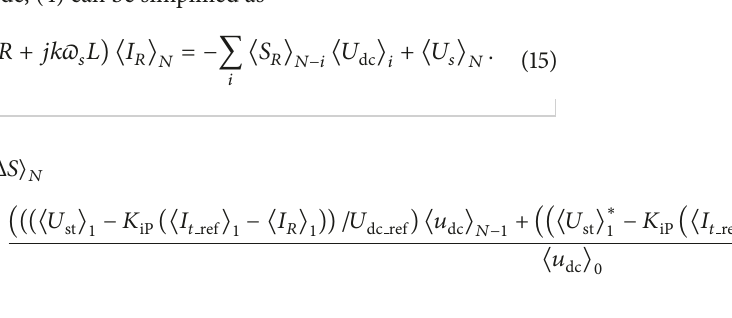
The harmonic currents on ac side are mainly induced by the grid voltage distortions and the internal interaction between the harmonic voltages on dc side just shown in Figure 3. The grid voltage distortions ⟨𝑈 𝑠 ⟩ 𝑁 are normally uncontrolled, mainly induced by other nonlinear loads. How- ever, the ac voltage of SPVSC ∑ 𝑖 ⟨𝑆 𝑅 ⟩ 𝑁−𝑖 ⟨𝑈 dc ⟩ 𝑖 can be easily controlled by adjusting controller. It can be implied from (15) that ⟨𝑆 𝑅 ⟩ 𝑁 ⟨𝑈 dc ⟩ 0 can be utilized to offset the harmonic currents generated by ⟨𝑈 𝑠 ⟩ 𝑁 and ∑ 𝑖 ̸=0 ⟨𝑆 𝑅 ⟩ 𝑁−𝑖 ⟨𝑈 dc ⟩ 𝑖 . If the right side of (15) is equal to 0, the internal interaction between the ac and dc side harmonics and external excitation from grid voltage distortions can be offset; thus the 𝑁 th harmonic current on ac side can be eliminated